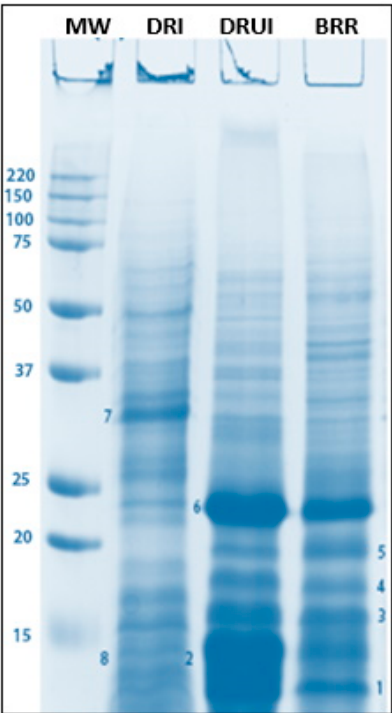
Figure 8. SDS-PAGE profile of the protein samples taken from the infected and non-infected rice grains of the Dharam variety and the resistant Black rice variety. Note: MW = molecular weight marker, DRI = Dharam rice grains infected, DRUI = Dharam rice grains non-infected, and BRR = Black rice-resistant